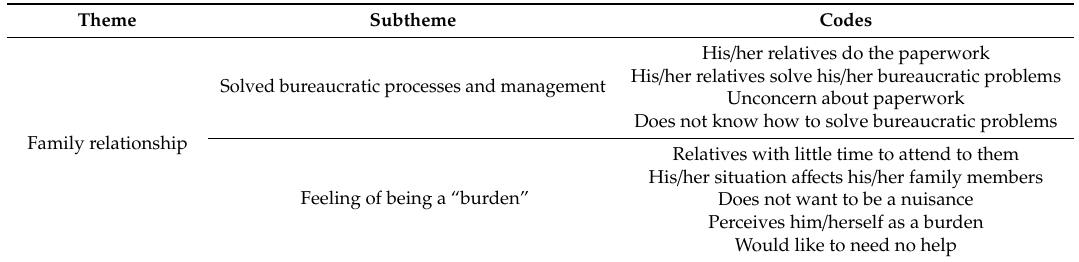
Table 7. Theme, subthemes, and codes related to the satisfaction of psychosocial needs of